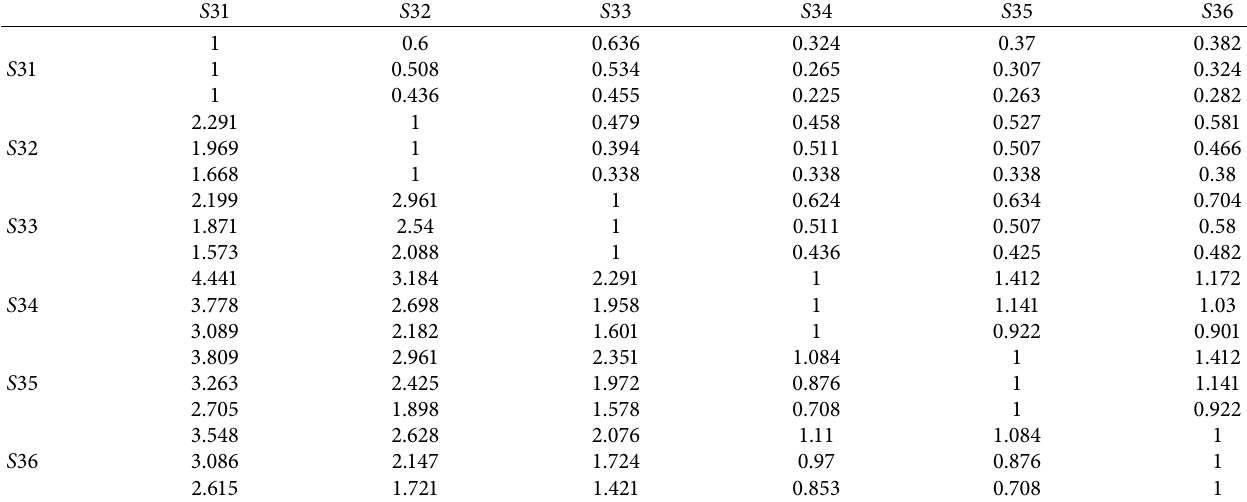
Table 9: Prioritizing the other factor subcriteria.